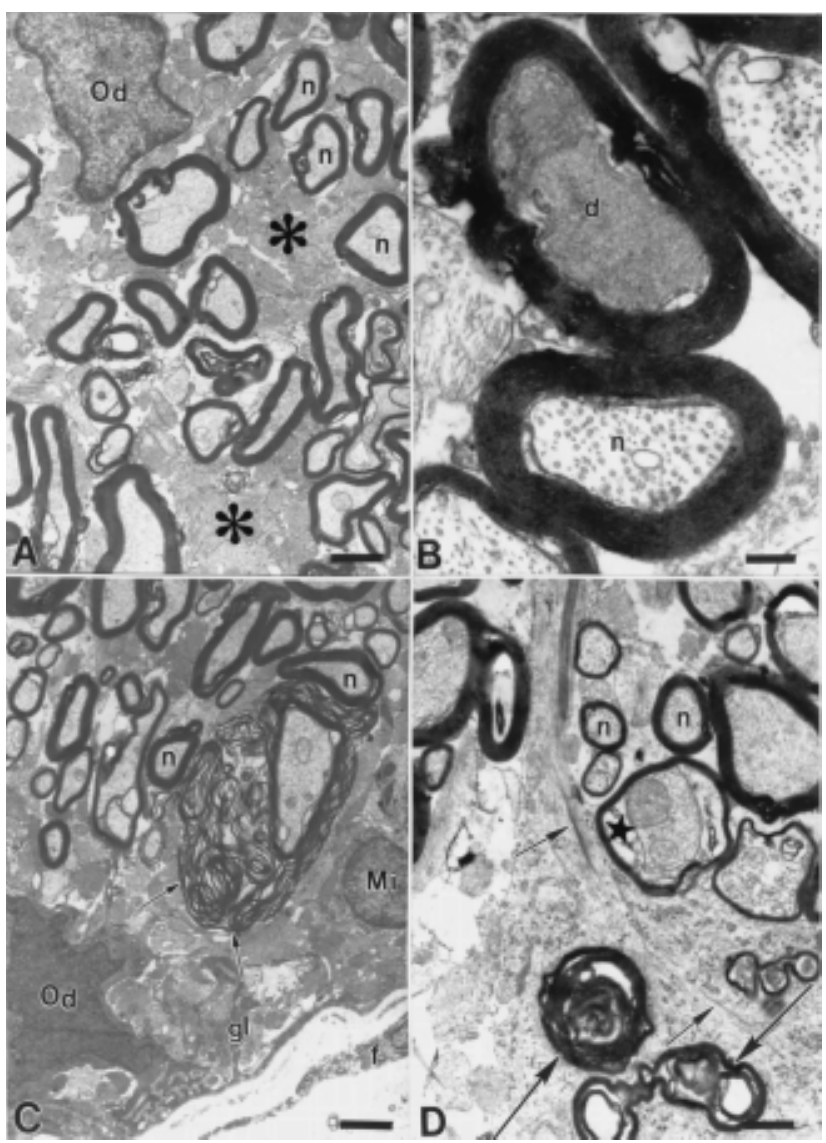
Fig. 3 – Electron micrographs of opossum’s optic nerve fibers undergoing Wallerian degeneration 96 hours after crush. A. Thick septa with abundant astrocytic processes (asterisks) are seen among the optic fibers. Many of them exhibit an apparently normal structure (n). An oligodendrocyte (Od) is seen at the left superior quadrant of this field. Bar = 1 . 7 µ m. B. A small-sized fibre is seen with the axoplasm filled with a dense and amorphous material, typical of dark degeneration (d). Normal looking fibers (n) are also observed. Bar = 0 . 25 µ m. C. Periphery of the optic nerve. An optic fiber shows an extensive vacuolization and consequent delamination of myelin lamellae (arrows); the axoplasmic cytoskeleton is apparently preserved in this fiber. Normal looking fibers (n) are also observed. Portions of somata of an oligodendrocyte (Od) and a microglial cell (Mi) can be seen next to the glia limitans (gl) in this field. f, fibroblast in pia mater. Bar = 1 . 7 µ m. D. A large astrocytic process contains lamellar debris (thick arrows) within its cytoplasm. Observe bundles of filaments (thin arrows) in the cytoplasmic process, typical of astrocytes. Normal (n) and altered (star) fibers (with axolemmal detachment from myelin) are seen. Bar = 1 . 1 µ